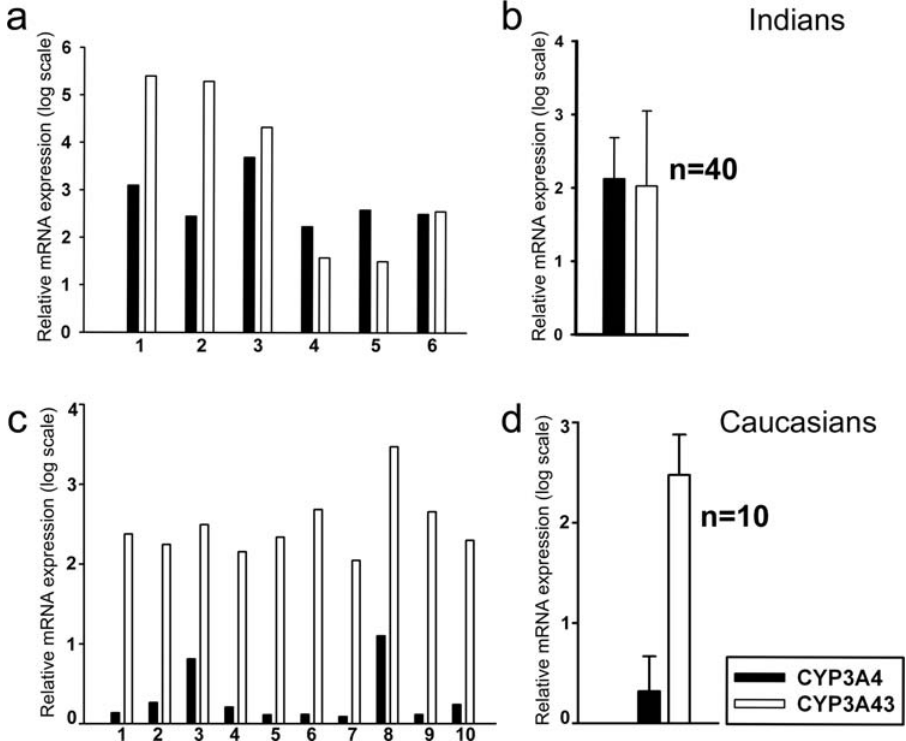
Figure 4. Expression of CYP3A43 and CYP3A4 in human brain samples from different population groups. Expression of CYP3A43 and CYP3A4 in 6 individual samples of human brain cortex obtained from Indians depict the inter-individual variation (a). Expression of CYP3A43 and CYP3A4 averaged across 40 samples of human brain cortex from India (b). Comparison of CYP3A4 and CYP3A43 transcripts among 10 Caucasian brain samples (c) demonstrated that on average (d) CYP3A43 expression is 170 fold higher than CYP3A4. All samples were normalized using 18S rRNA.